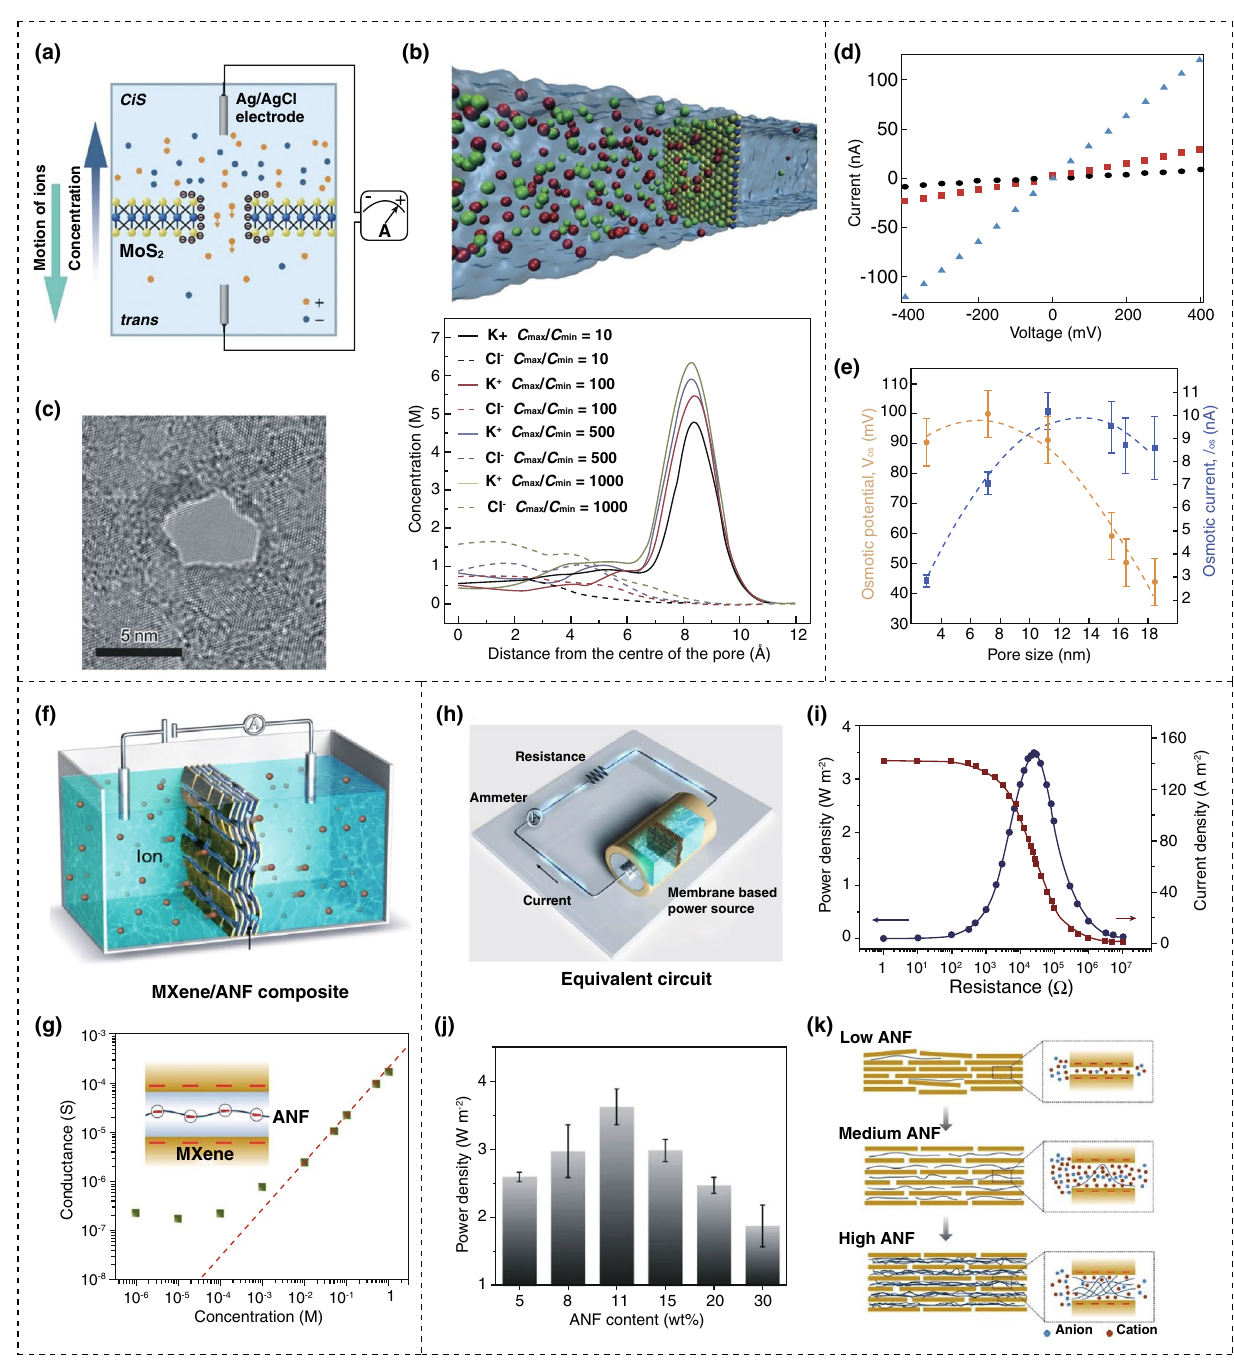
Fig. 9 Working mechanism of osmotic power generation. a Arrangement of module by membrane separating the solutions with different den- sity. b A simulated distribution of ions in solution. c MoS 2 nanopore membrane, drilled with transmission electron microscope with 5 nm diam- eter. d Output current, and voltage according to the pore size. e Osmotic voltage and current according to pore size. f Schematic of the device arrangement. g Calculation of conduction with the varying concentrations. h Setup for transporting generated power to external load circuit. i Generated power density by the membrane. j Effect of aramid nano-fiber concentration on output power. k Illustration of aramid nano-fiber frac- tion on overall energy conversion. Figures reprinted with permission from: a , b , c , d , e Ref. [122], © 2016 Nature; f , g , h , i , j , k Ref. [13], © 2019